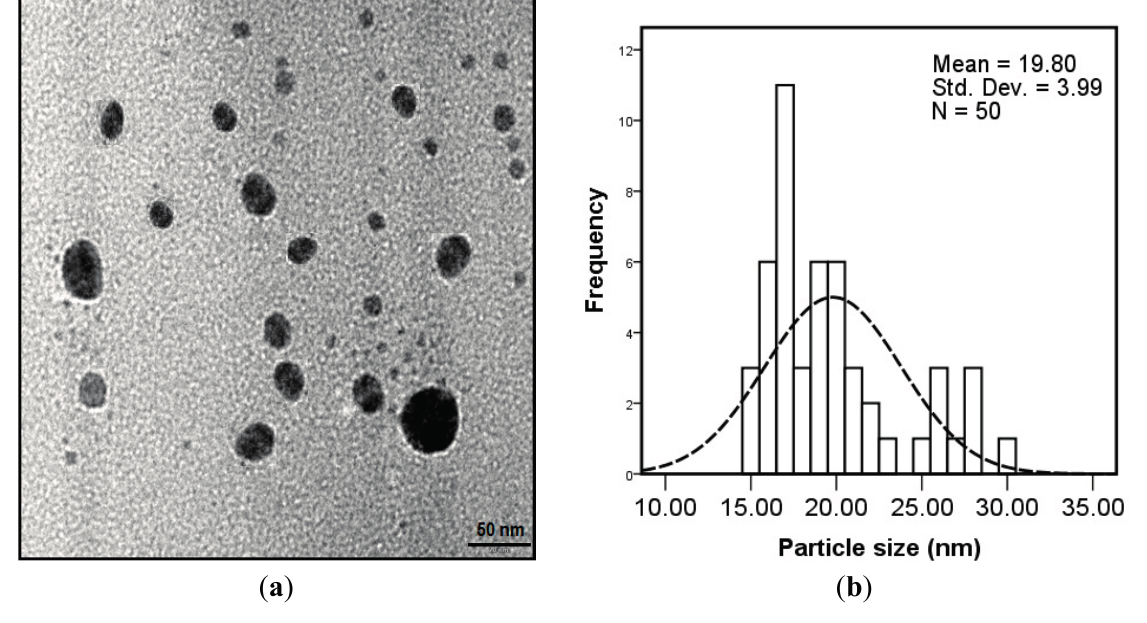
Figure 4. TEM image ( a ) and particle size distributions ( b ) of bio-synthesized nanoparticles.